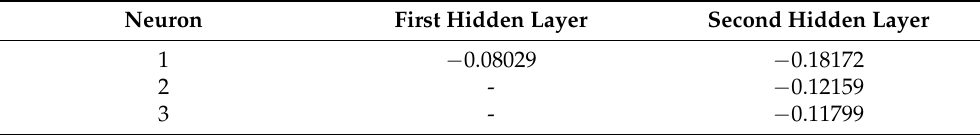
Figure 11. Neural network with one neuron in the first and three neurons in second hidden layer. Table 3. Network error. Neuron